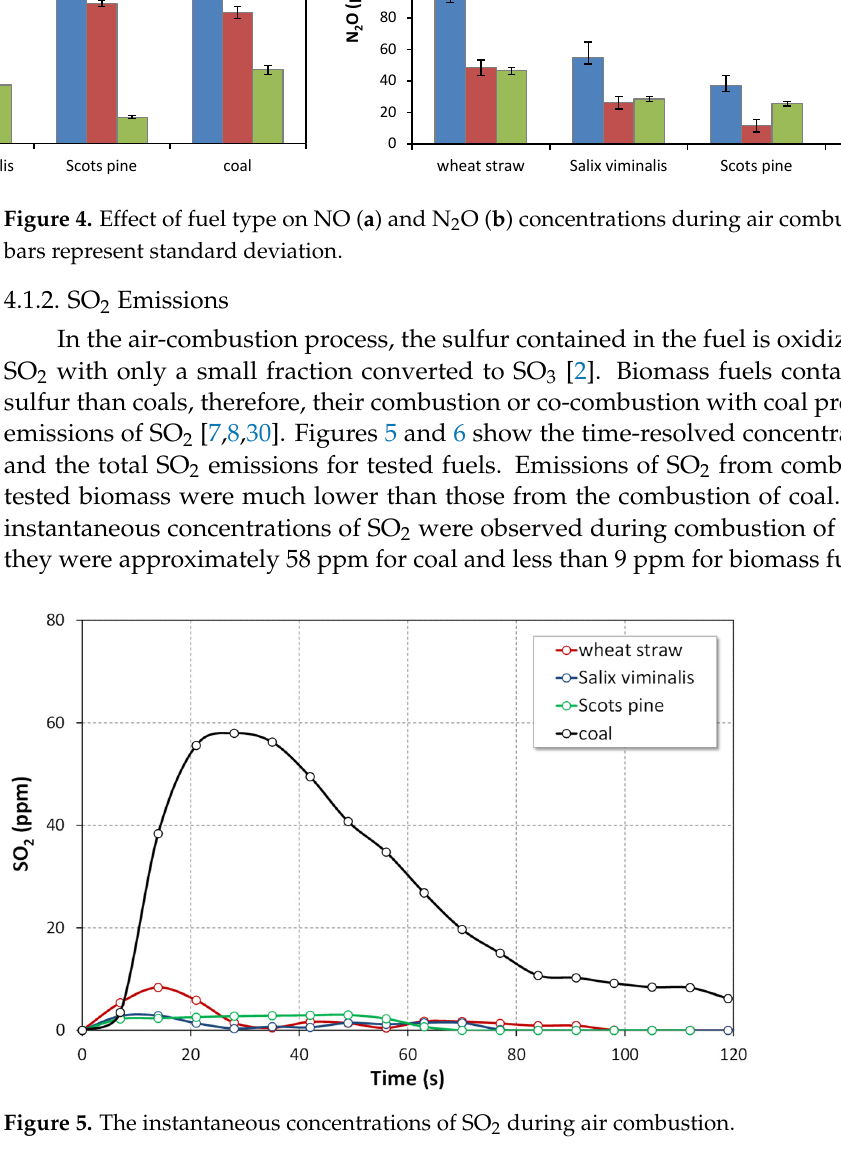
Figure 3. The instantaneous concentrations of NO and N 2 O during air-combustion of wheat straw.